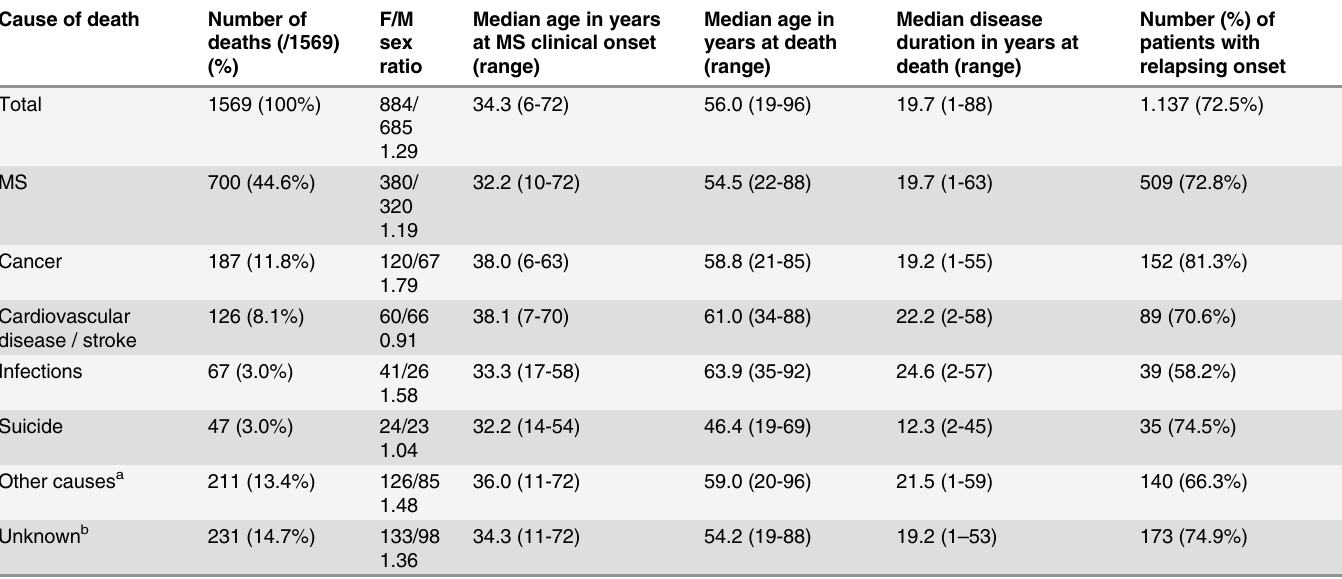
Table 2. Characteristics of the 1569 deaths categorized by underlying cause of